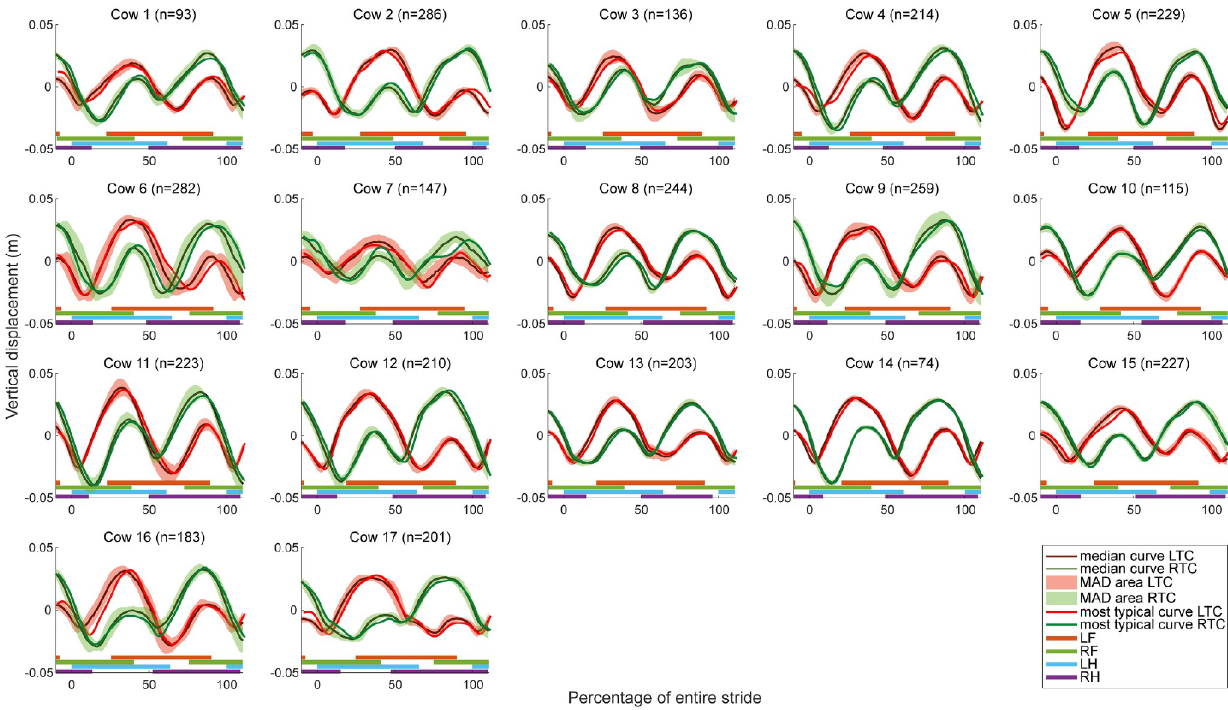
Fig 10. Vertical displacement curves of the left and right tuber coxae. Per cow, the median curve, MAD area and most typical curve is shown for the LTC (red) and RTC (green) on a scale from zero to 100% of the entire stride duration. The stance phases of the limbs are indicated by the horizontal lines underneath the curves (orange: LF, green: RF, blue: LH, purple: RH).